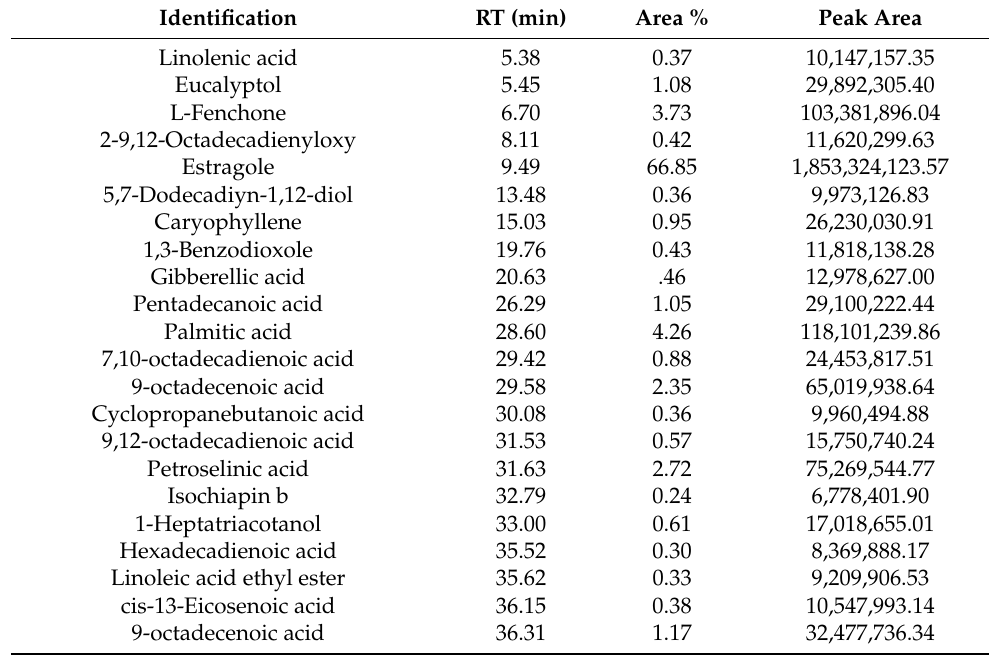
Table 10. Chemical composition of aniseed extract After GC analysis.